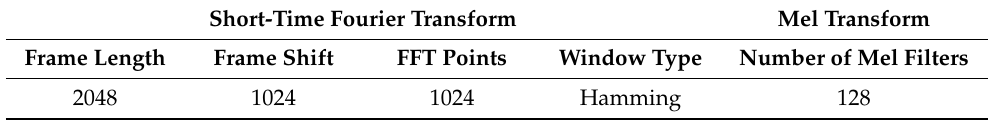
Table 1. Log-Mel spectral transform specific parameters.